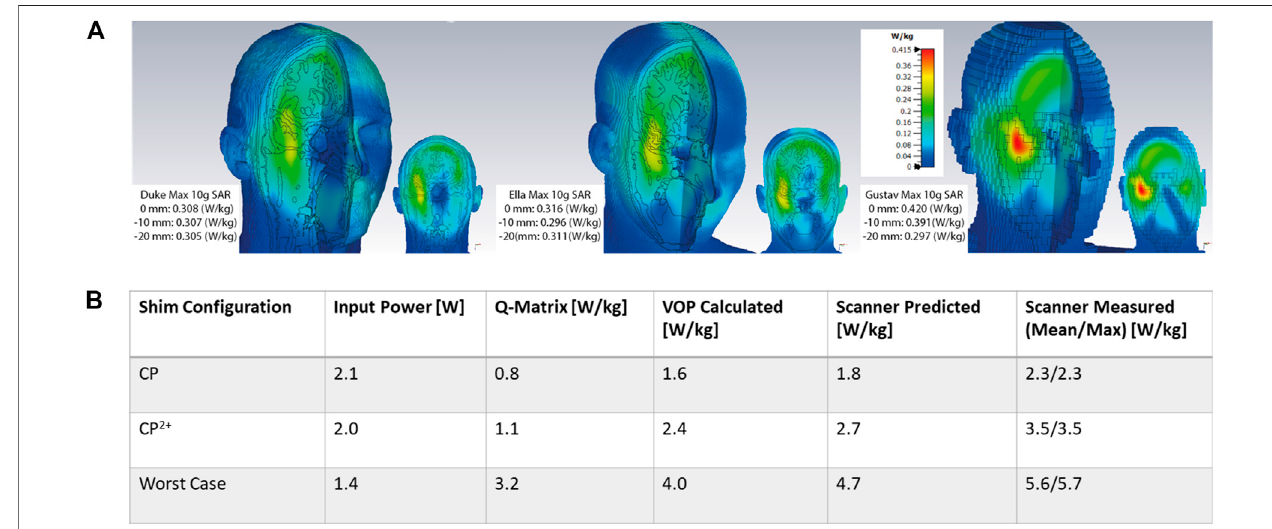
FIGURE 8 | (A) 3D CST simulations of 10 g-SAR with 1W of input power for Duke, Ella, and Gustav body models all positioned at the B 0 fi eld isocenter with the samecolorscalingoneachmodel.ThemaxSARvalueforeachmodelforallthreepositions(z (cid:2) 0, − 10,and − 20 mm)islistedinthelefthandcornerforeachbodymodel. (B) Comparison of local SAR values for concatenated body model Q-matrices, VOP compressions calculated of fl ine, and values reported by scanner during predicition and measurement.